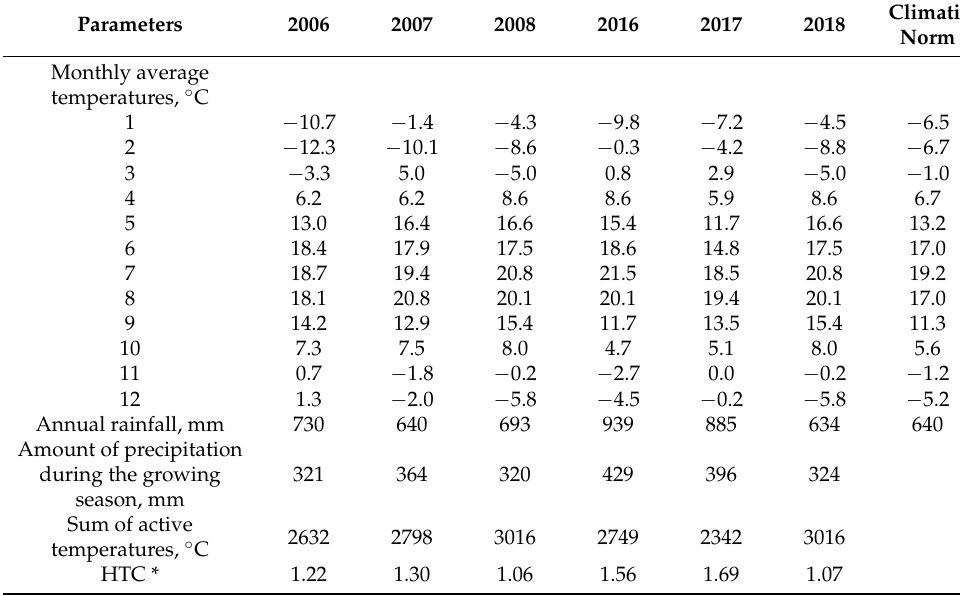
Table 5. Weather conditions for two periods of simulation.